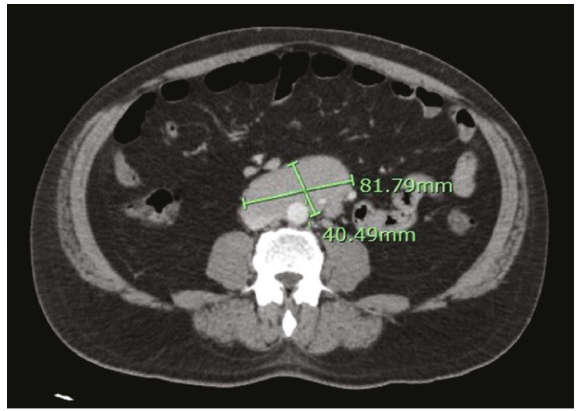
Figure 3: CT Abdomen and Pelvis with contrast showing enlarged preaortic lymph node (measured as 8 × 4 cm on axial view).